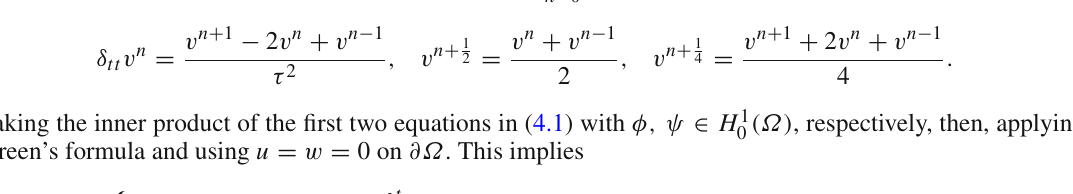
and work instead on the finite interval ( 0 , T ] with T that can be sufficiently large. Divide [ 0 , T ] uniformly into N subintervals each with size τ := T / N and nodes { t n } N